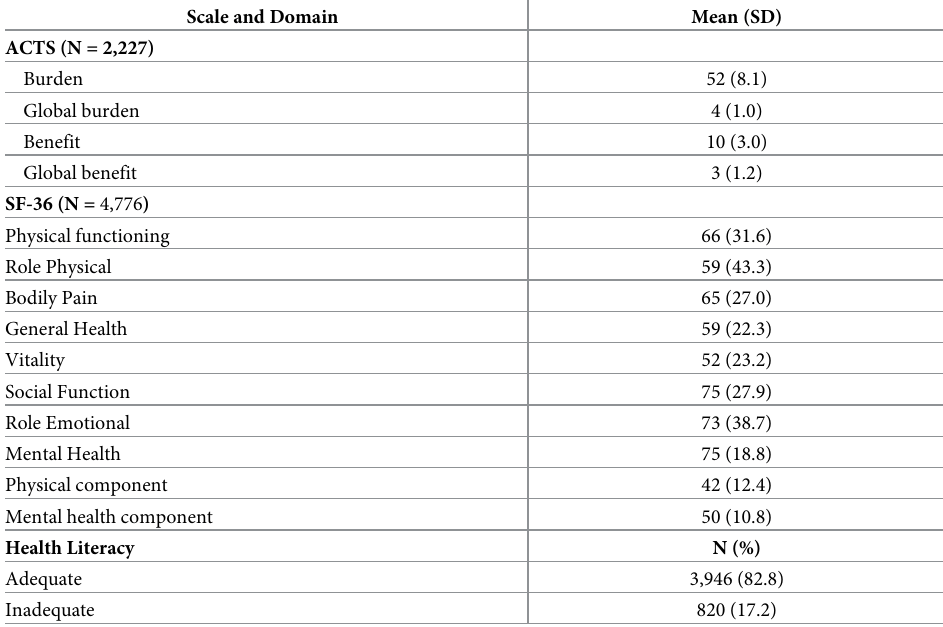
Table 4. Summary scores of the patient-reported outcomes and health